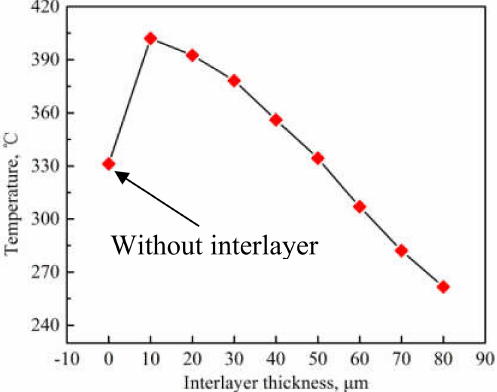
Figure 8. Temperature of the weld interface for the joints with different interlayer thicknesses.